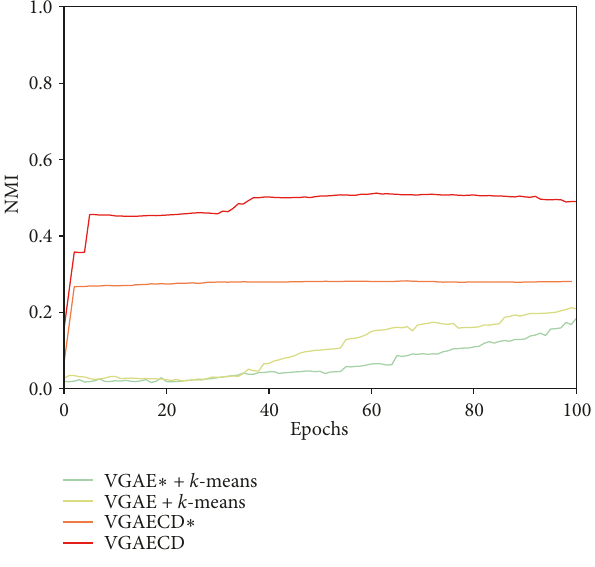
Figure 3: NMI convergence